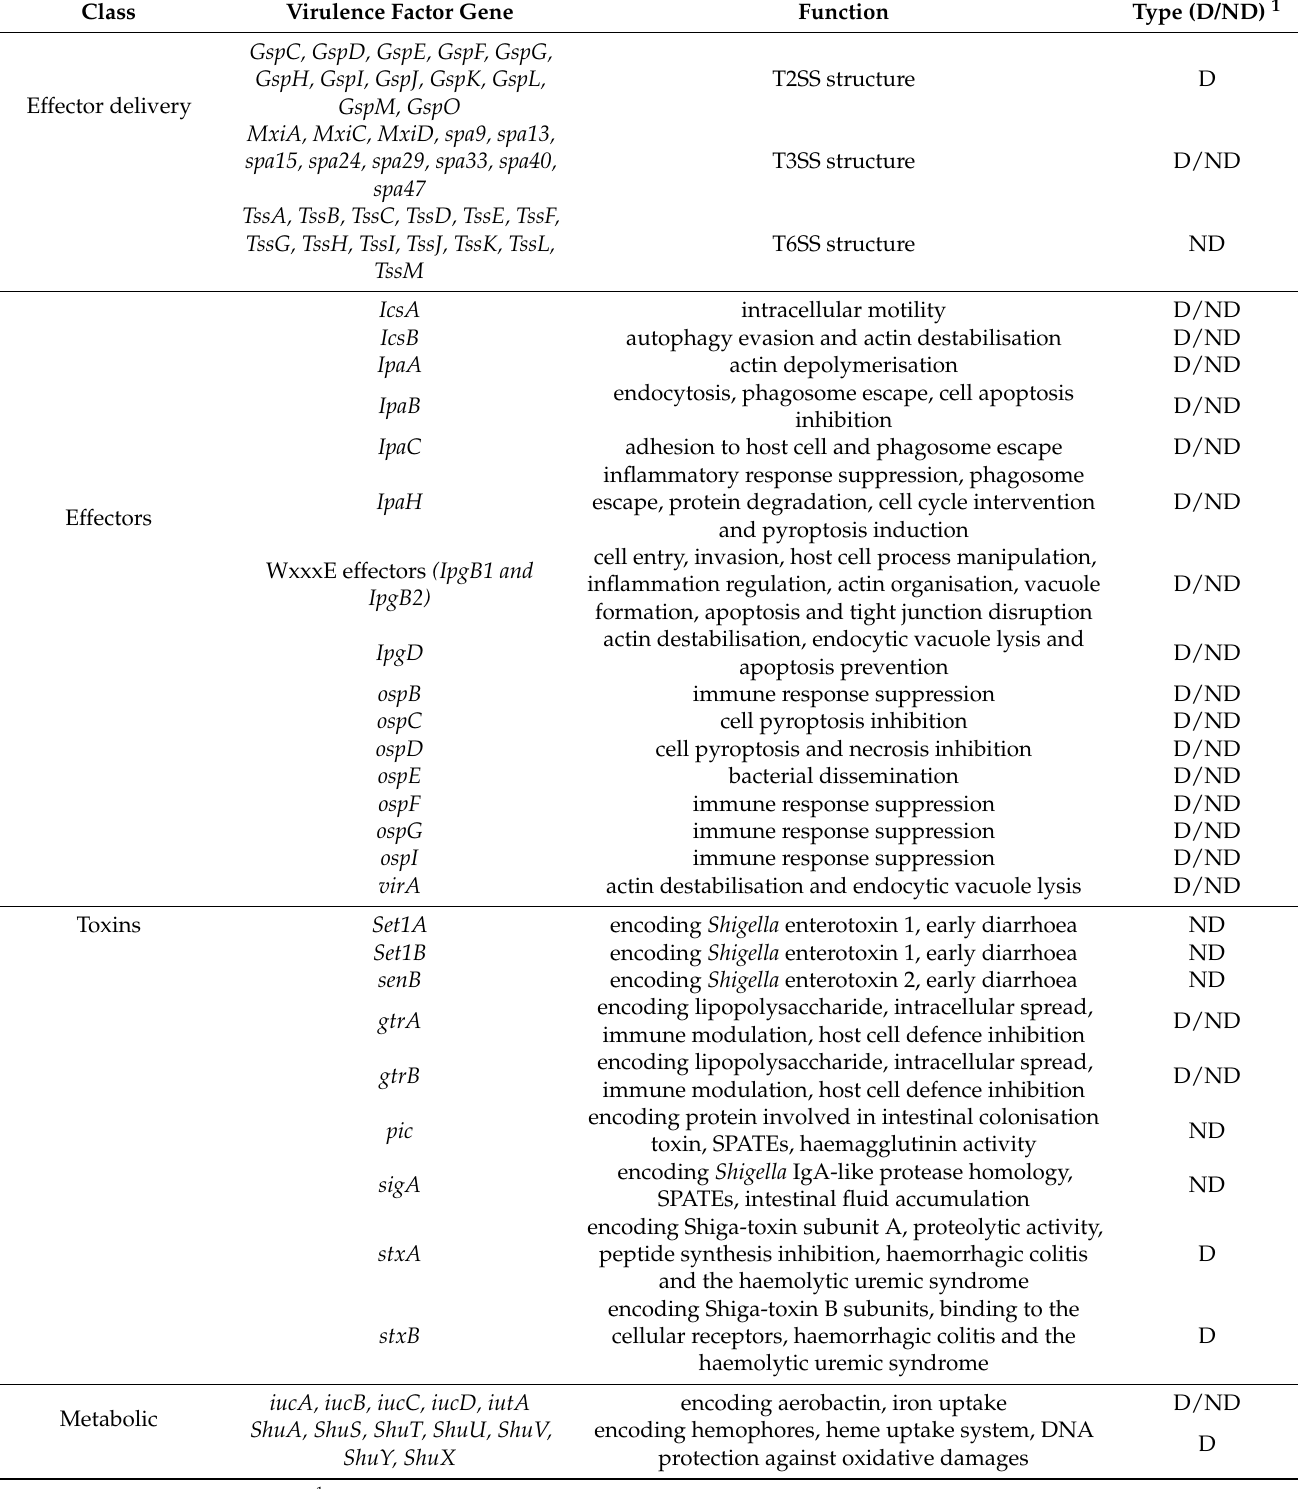
Table 1. Virulence factor encoding genes in Dysenteriae and non-Dysenteriae Shigella